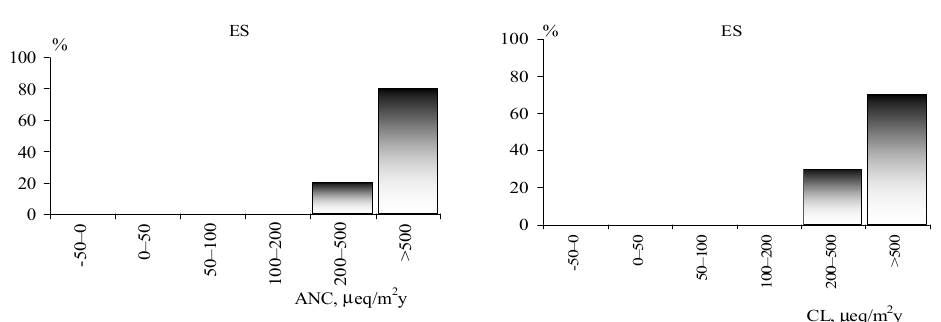
Figure 3. The percentage distribution of lakes according to the values of water acid-neutralizing capacity (ANC) and critical loads (CL) in the Arctic regions of the European territory of Russia (ER), Western (WS) and Eastern Siberia (ES).